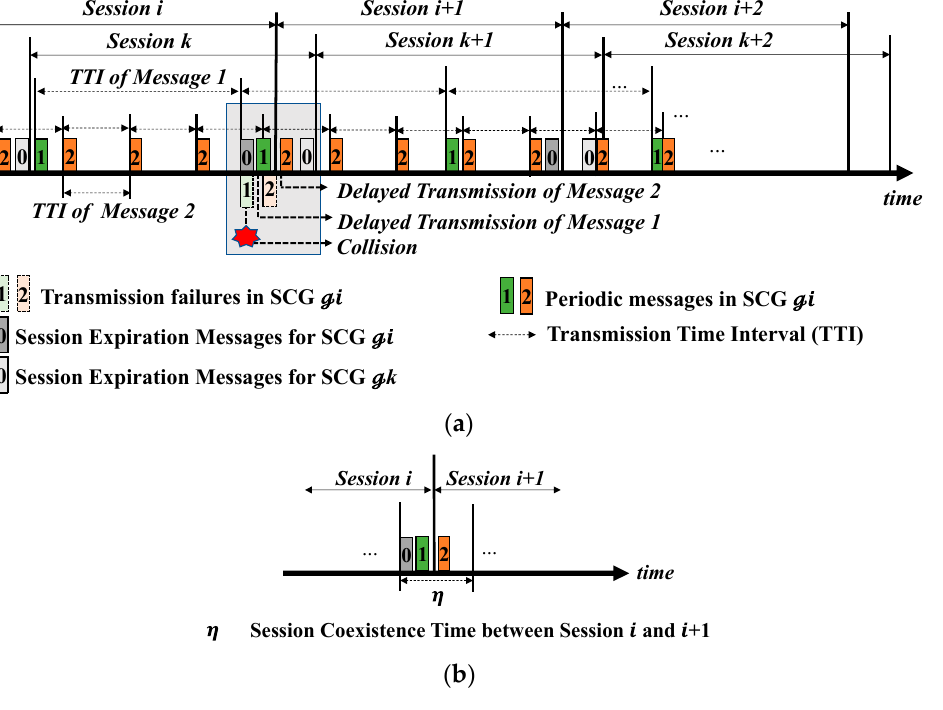
Figure 5. A grace period to use the old and new session keys together for origin authentication: ( a ) Problems of collisions and delayed transmissions; ( b ) session coexistence time.